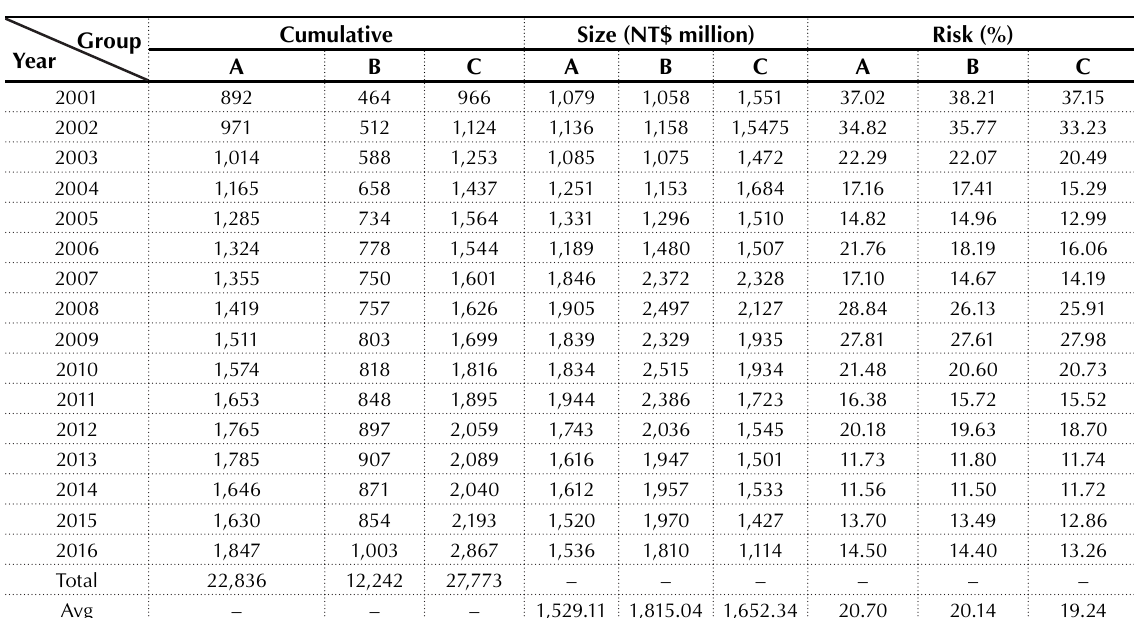
Table 1. Fund cumulative number, size, and risk